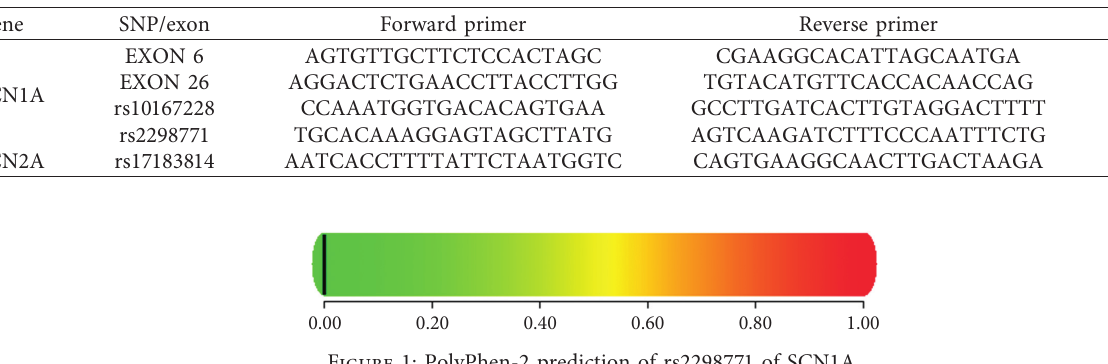
Table 1: Primers used for the selected SNPs.